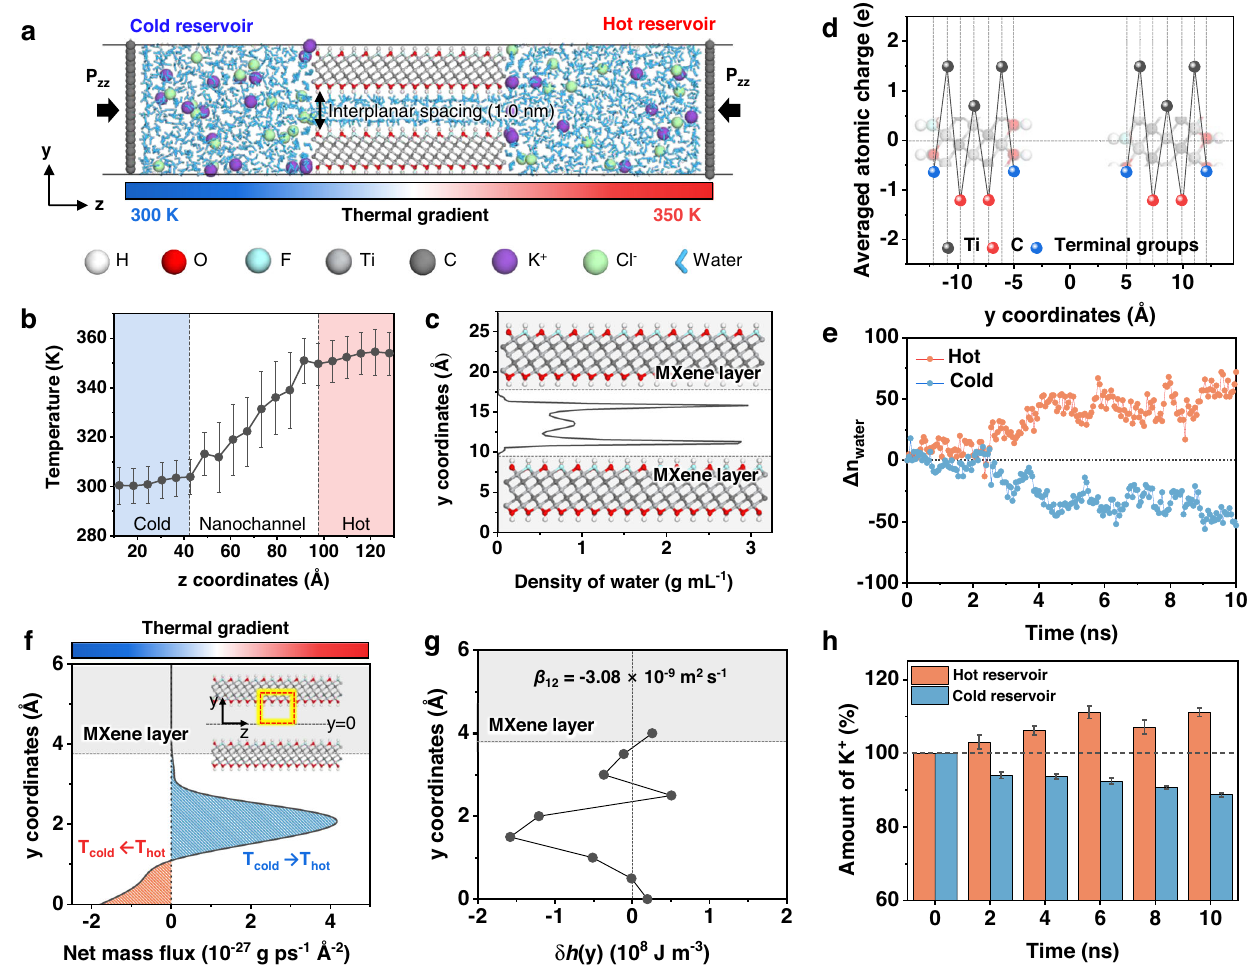
Fig. 4 | MD simulation of ion fl ow in the MXene nanochannel. a Simulation system of the MXene nanochannel in electrolyte reservoirs at two different tem- peratures. P zz represents the pressure applied on piston walls along z direction. b Temperaturepro fi leofthesolutionintheentiresystemalongthedirectionofthe z axis, and c density pro fi les of the fl uid in the MXene channel along the y axis. d Averaged atomic charges of the MXene components. The terminal groups of MXene indicate the averaged charges of the O, OH, and F groups. e Change in the number of water molecules ( Δ n water ) in the coldand hot reservoirs. f Net mass fl ux